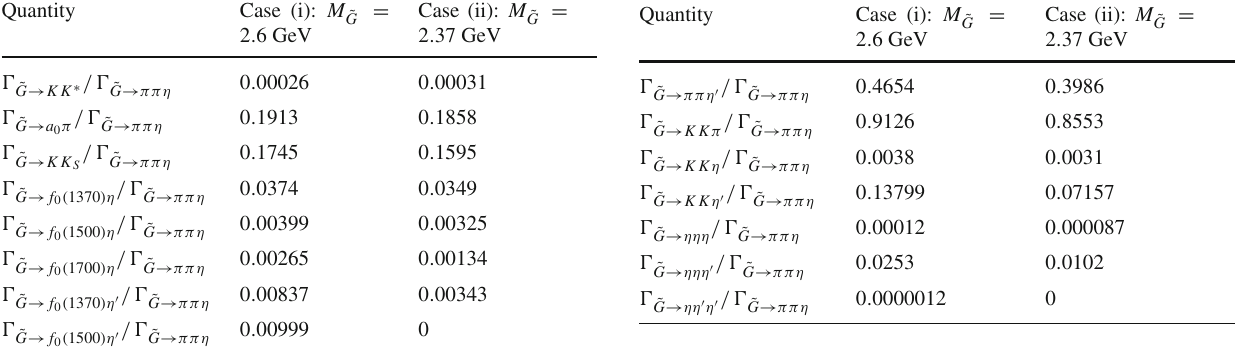
Table 3 Branching ratios for the decay of the pseudoscalar glueball ˜ G into three pseudoscalar mesons Quantity